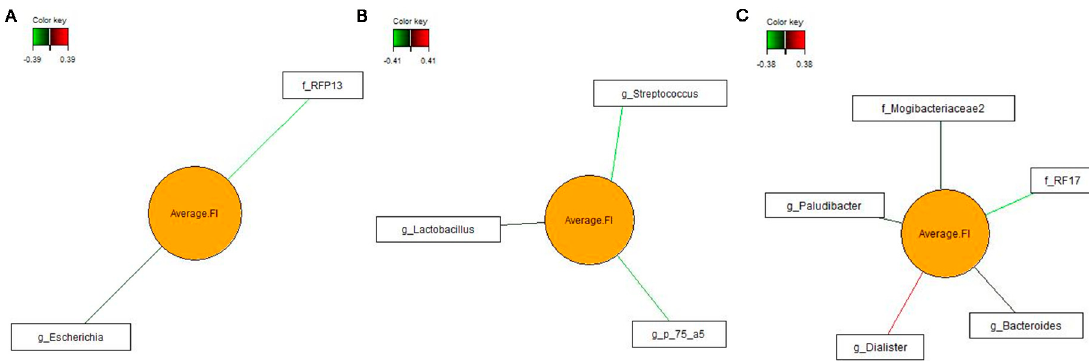
Figure 2. Relevance networks illustrating pairwise associations between most discriminant bacterial genera and average daily feed intake (Average_FI; | r | > 0.3). Covariations were calculated using sparse partial least squares regression. The relevance network is displayed graphically as nodes (bacterial genera and average feed intake) and edges (biological relationship between nodes). The edge color intensity indicates the level of the association: red = positive, and green = negative. g_, genus; f_, family. ( a ) Week 3; ( b ) week 5; and ( c ) week 10.